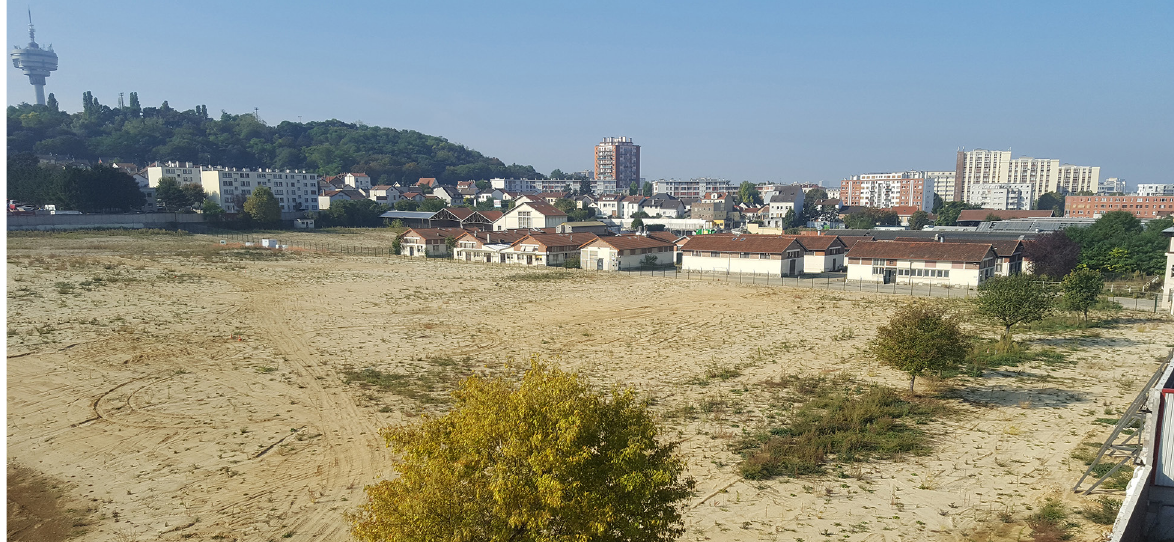
Fig. 4. Land clearance in Bobigny-Romainville, ready for high-value residential development. Photo by Florian Weber